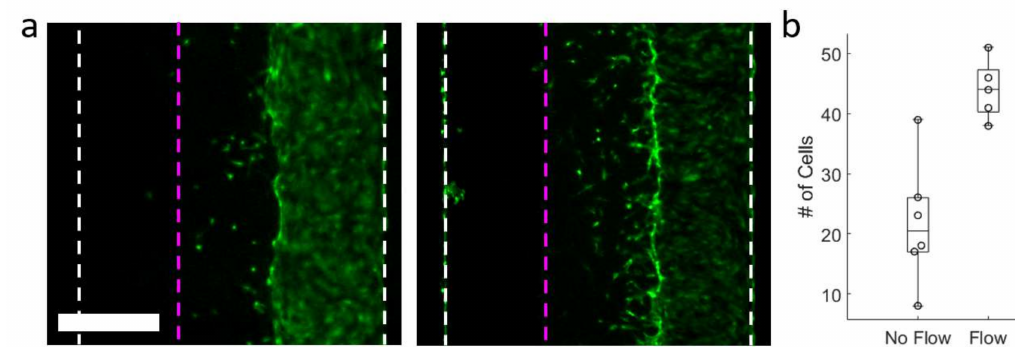
Figure 5. Endothelial cells migrate into patterned gels when trans-gel flow patterns are applied. ( a ) Green Fluorescent Protein (GFP)-expressing human umbilical vein endothelial cells (HUVEC) to small extent migrate into gels without any physical cues ( left ), but migrate significantly more when they are subjected to a trans-gel flow ( right ). The boundary between the gel and the non-cultured fluidic access channel is indicated by the dotted pink lines and the dotted white lines indicate the walls of the microfluidic channel. Scale bar is 0.5 mm. ( b ) Quantification of migration data shows a significant di ff erence between conditions of no trans-gel flow and with trans-gel flow ( p < 0.05). All data points are shown while boxes and whiskers denote data